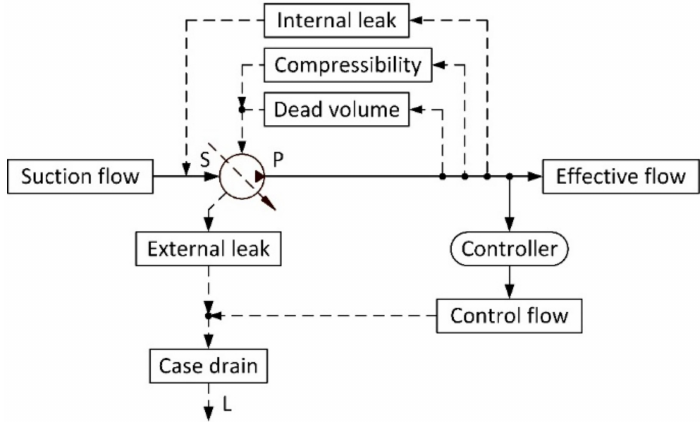
Figure 3. Flow rates of a variable displacement